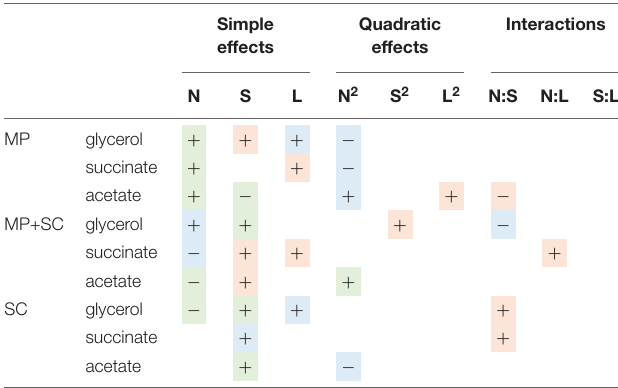
TABLE 5 | Effects of must parameters on the production of glycerol and acetate by M. pulcherrima in pure culture after 48 h of fermentation (MP), M. pulcherrima and S. cerevisiae under sequential inoculation (MP + SC) and S. cerevisiae in pure culture